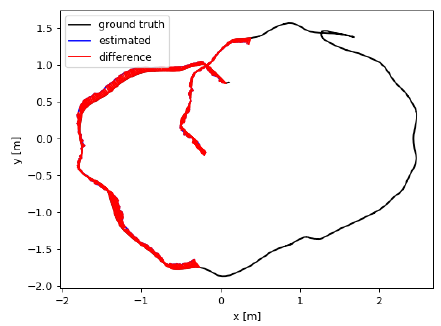
Figure 9. Kidnapping simulation using sequence F2K. Estimated and ground truth trajectories. Red line stops while camera pose is unknown due to